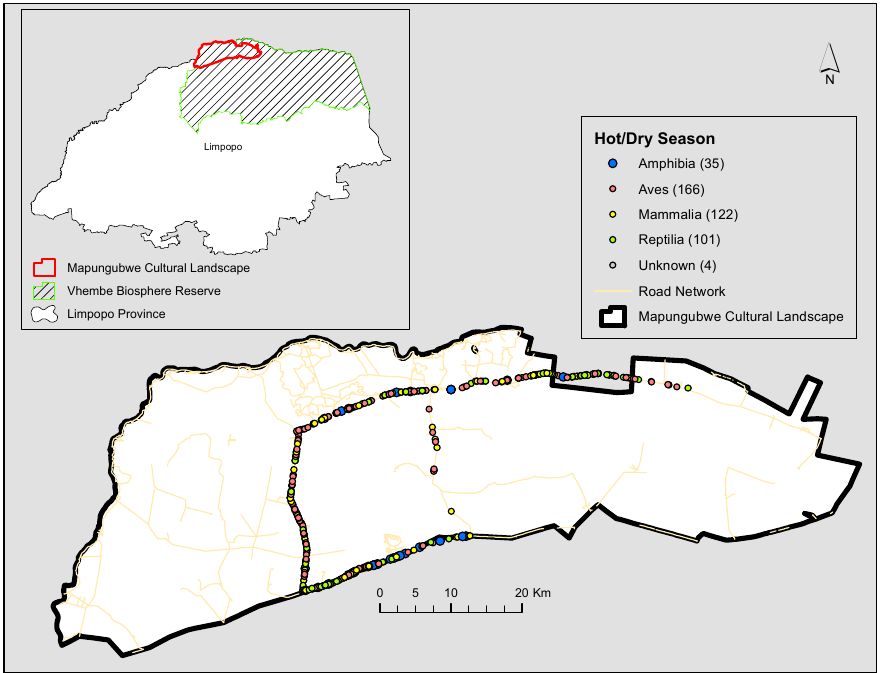
( a ) Hot–Dry Season